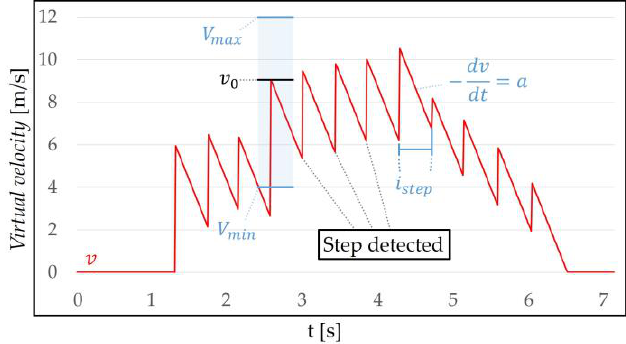
Figure 10. This shows the virtual velocity when using WIP: v (m/s). This is the result when 𝑣 0 ∈ [4, 12] , a = 9 m/s 2 . If a step is detected, v is updated to new 𝑣 0 .